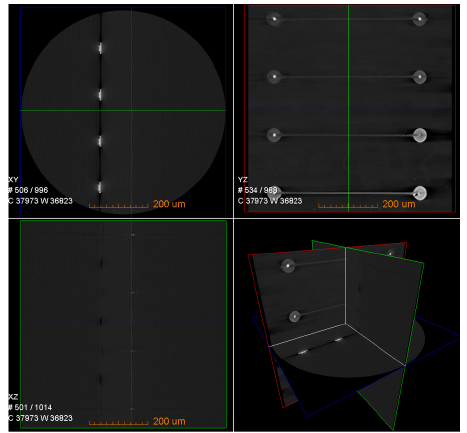
Figure 12. Three-dimensional stereogram, XY section, YZ section and XZ section morphology in the local magnification scanning.